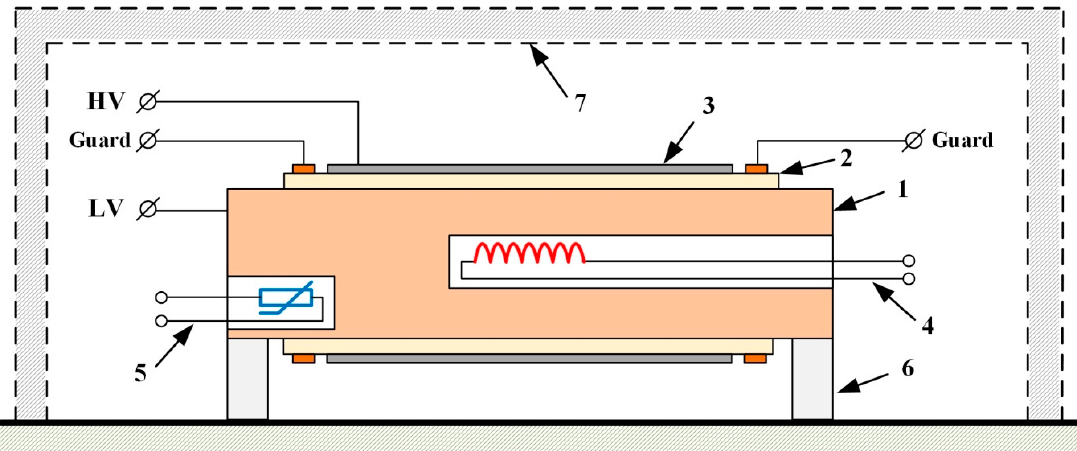
Figure 3. View of the measuring electrode system and the insulation sample studied: 1—a roll made of brass (LV—low potential electrode), 2—aramid–oil insulation sample, 3—metal foil (HV—high potential electrode), 4—heater, 5—temperature sensor, 6—insulator, 7—hermetic vessel plus thermal insulation.